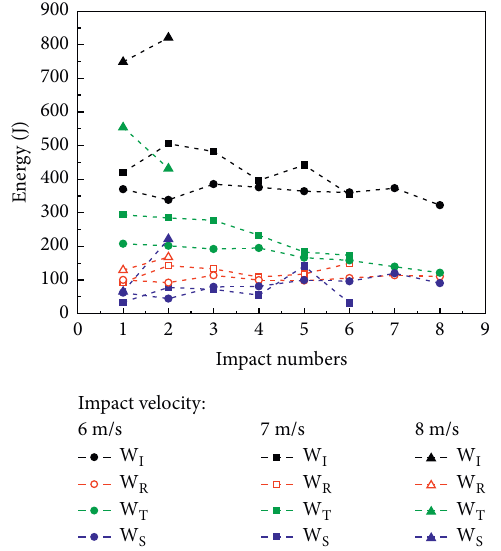
Figure 10: Variation of diferent kinds of energy with impact